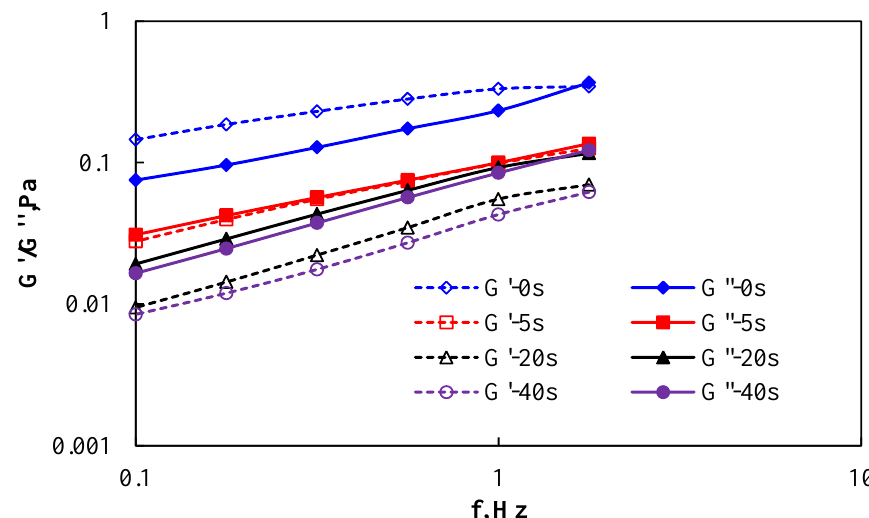
Figure 2. Effect of shear on the viscoelasticity of AP-P4 at a concentration of 1000 mg/L.